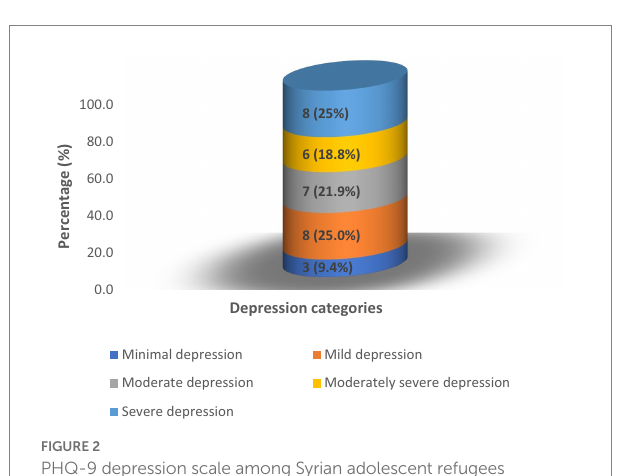
Supplementary Table 1. Any positive screening in the depression or